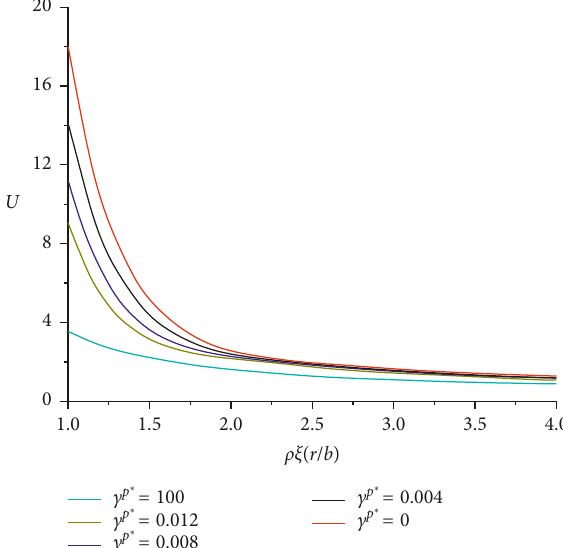
Figure 23: Variation of the dimensionless radial displacement considering seepage force with the change of c p Hoek–Brown rock